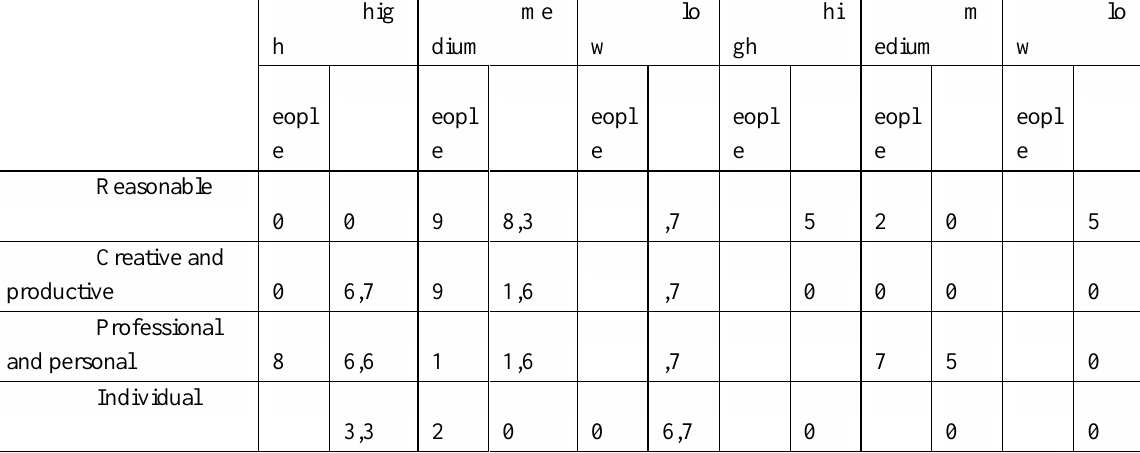
Table 3. Research methodology of the level of students’ awareness of the expediency of using research competence in various types of professional activity. The level of awareness of the expediency of using research competence